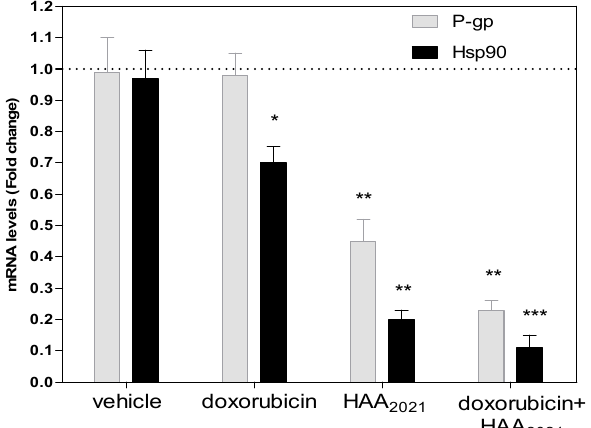
Figure 13. The inhibitory effect (72 h) of vehicle control, doxorubicin (1 µ M), HAA 2021 (0.25 µ M) or their combination on the expression of mRNA of P-gp in MCF7/ADR cells was quantified by RT-PCR. The data represent the mean ± SD of the fold change related to the vehicle control (fold change = 1 dashed line, n = 2 × 2 independent experiments). p < 0.05 (*), p < 0.01 (**), and p < 0.001 (***) were considered significant.